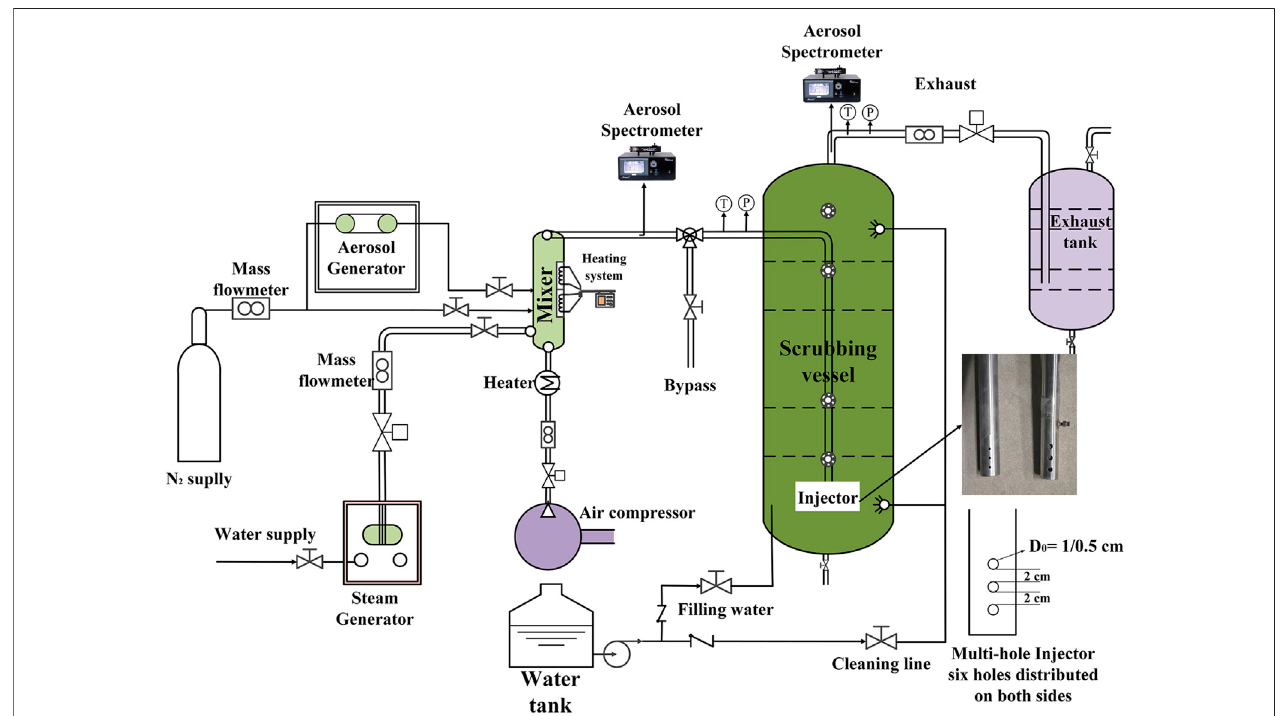
FIGURE 1 | Schematic of small-scale aerosol pool scrubbing facility.